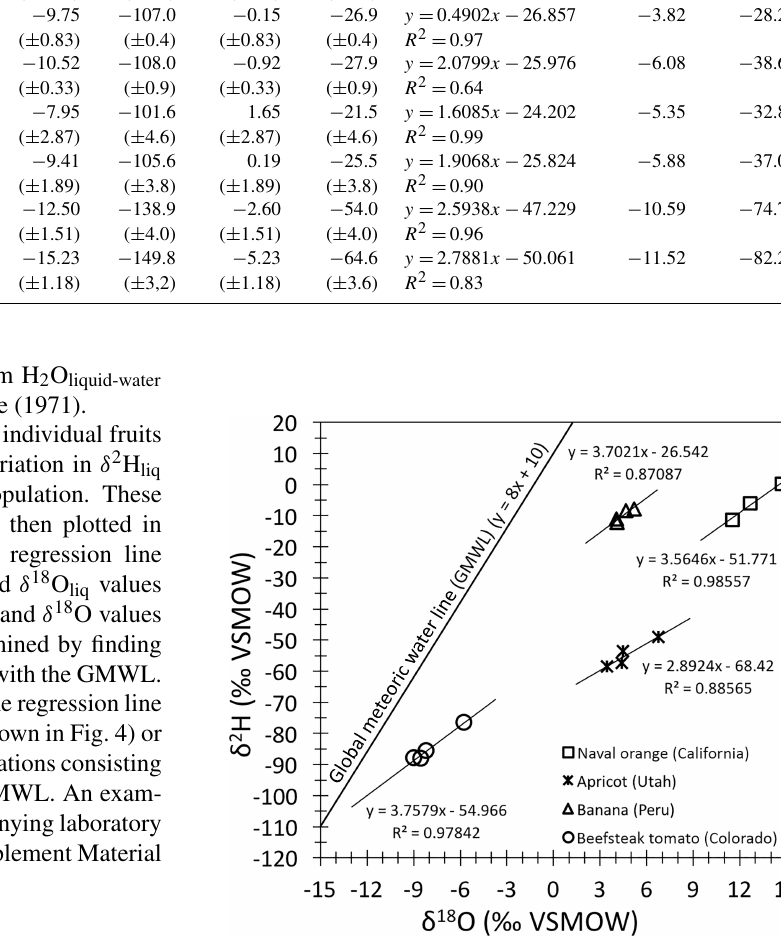
Figure 3. Values of δ 2 H liq and δ 18 O liq (symbols) calculated from measured δ 2 H vap and δ 18 O vap values (not shown) for various fruits and their associated regression lines compared to the global mete- oric water line